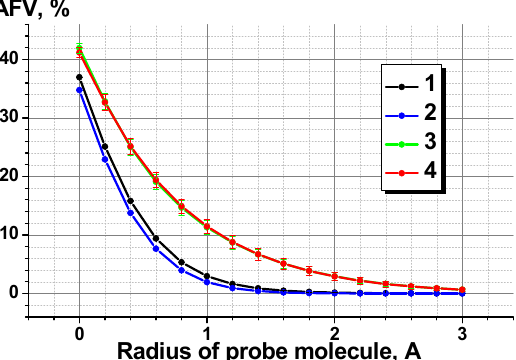
Figure 7. Dependence of accessible free volume on the size of probe. 1: Ultem, 2: PEI-304, 3: PTCNSi 2 v, 4: PTCNSi 2 g. The bars indicate the standard deviation.